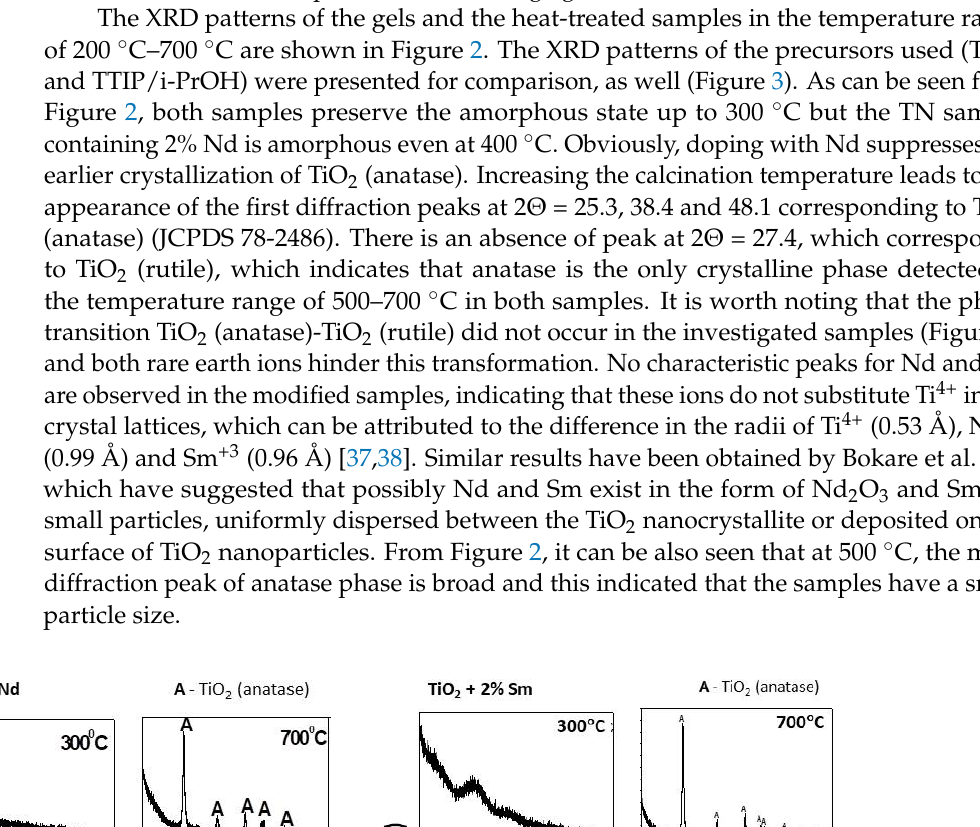
Figure 1. Images of the as-prepared gels.